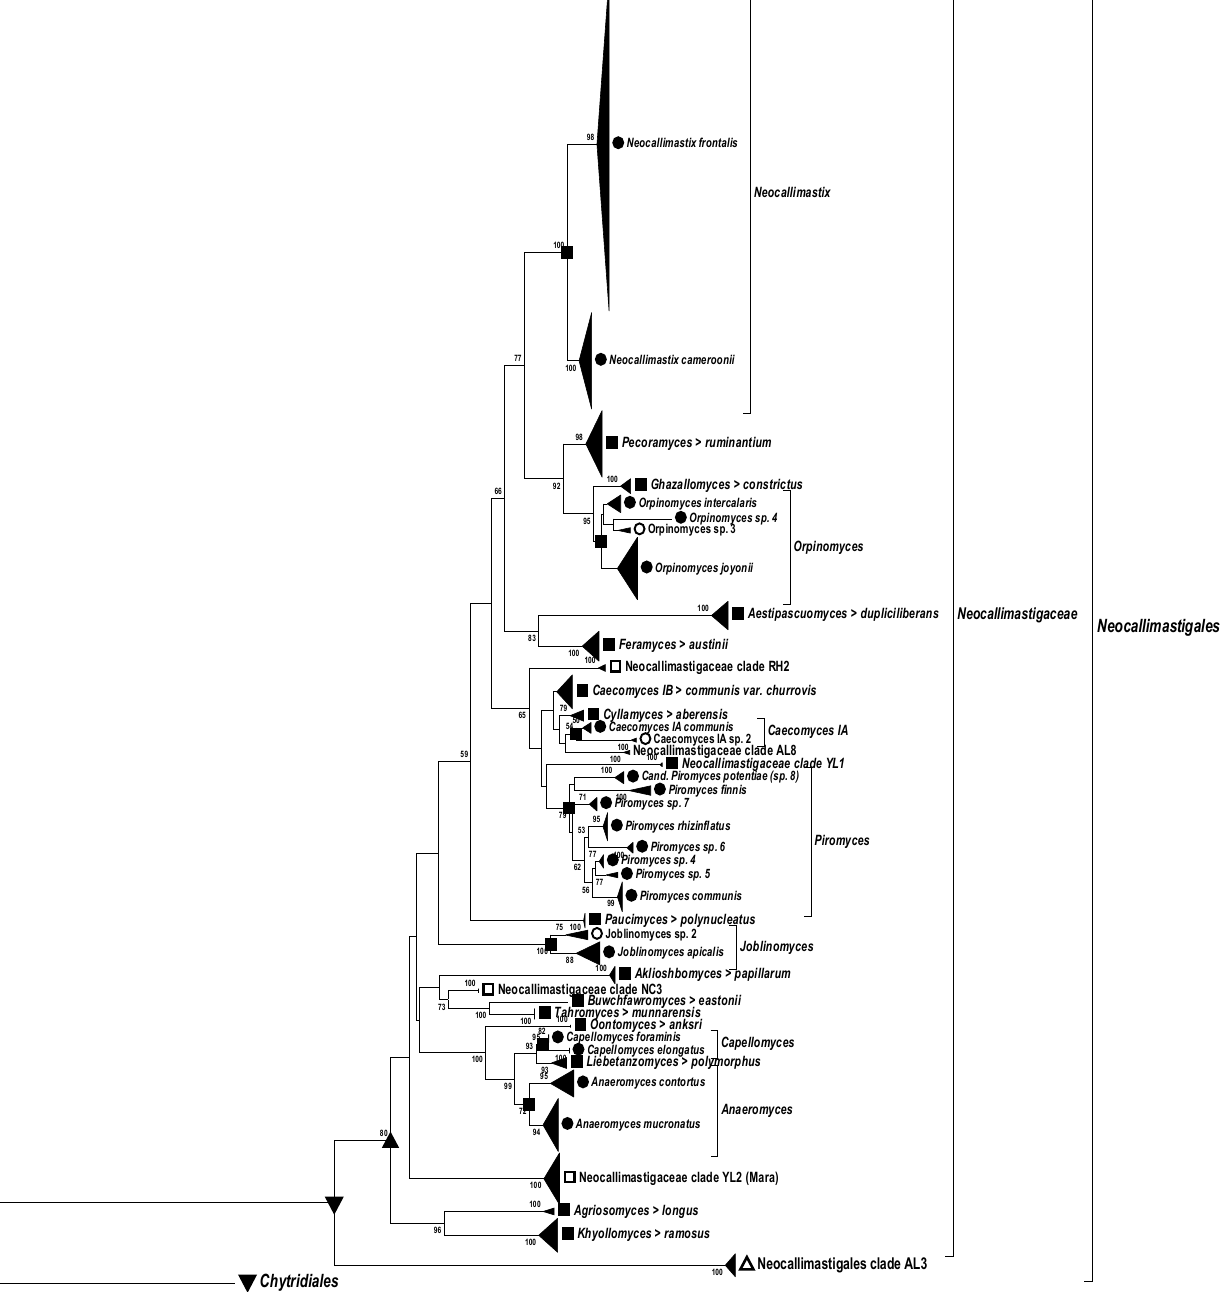
Figure 6. Compressed phylogenetic tree of the AGF LSU D1–D2 region. DQ536493 ( Chytriomyces sp. WB235A) was included as an outgroup. Filled symbols: reference strain(s) of a validly published species is available; valid taxonomic assignments are in italics. Open symbols: No cultured reference strain available, species defined only by genetic traits “genospecies”. Filled triangles pointing left: compressed clade. Triangle pointing down: Order level node. Triangle pointing up: Potential family level node. Square: Genus level node (established or >95% sequence identity); “>” in assignments means that the clades have genus level but only one species can be shown. Circle: Species-level node (established or >98.5% sequence identity). The expanded phylogenetic tree is added as Supplemen- tary Data S3.